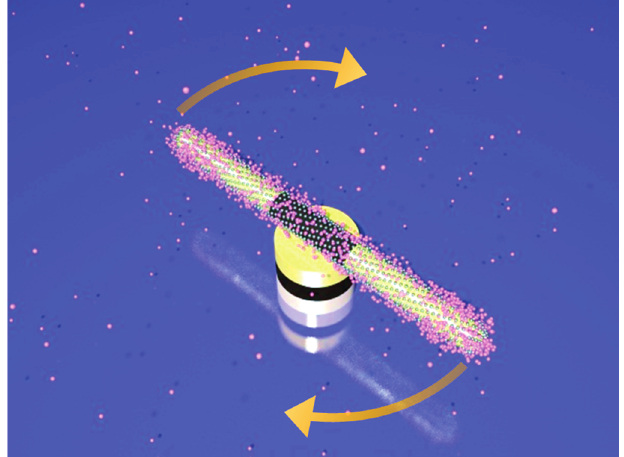
Figure 16. Schematic diagram of molecule release from a rotary plasmonic nanomotor [105]. With permission from [105].